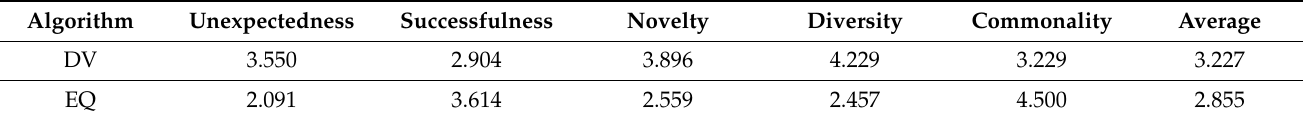
Table 2. User ratings of recommendations from the two algorithms across the five measurement categories. Algorithm Unexpectedness